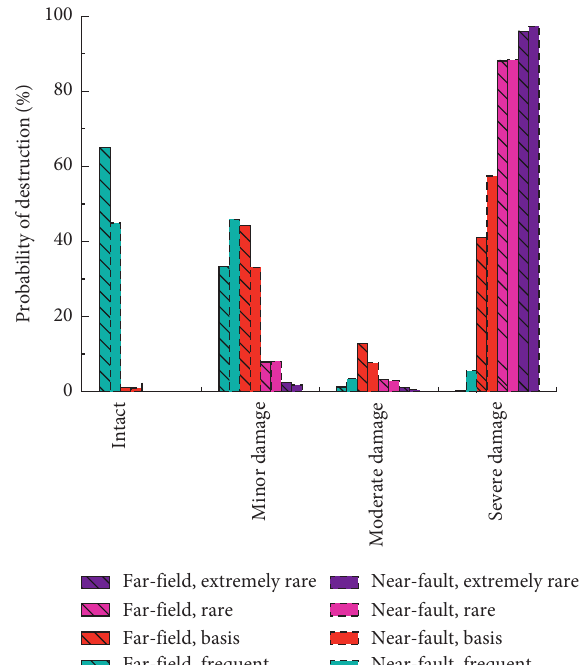
Figure 12: The failure probability of the tunnel structure under the action of different ground motions: (a) near-fault pulsed; (b) far-field.